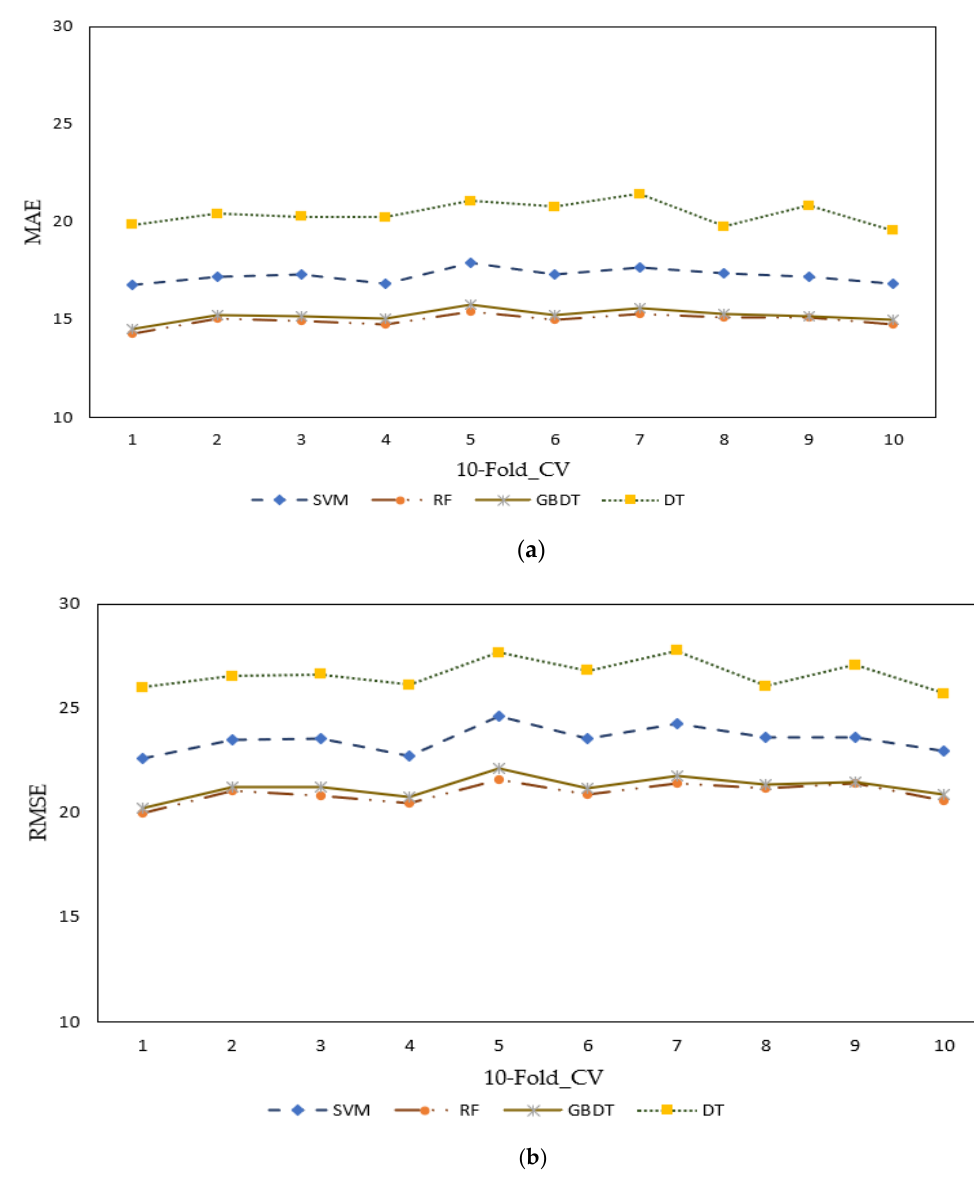
Figure 5. MAE and RMSE of the four ML method with 10-fold cross-validations. ( a ) Mean absolute error (MAE) graphical result representation, and ( b ) root mean squared error (RMSE) graphical result representation. Table 4. Comparative results of the four ML algorithms based on the feature selection technique used. Pearson